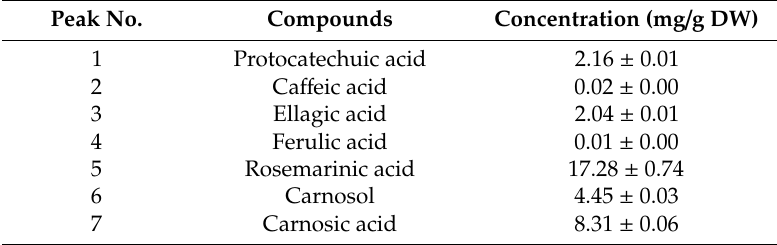
Table 1. Major phenolic compounds in rosemary